Question: Produce a descriptive caption suitable for publication.
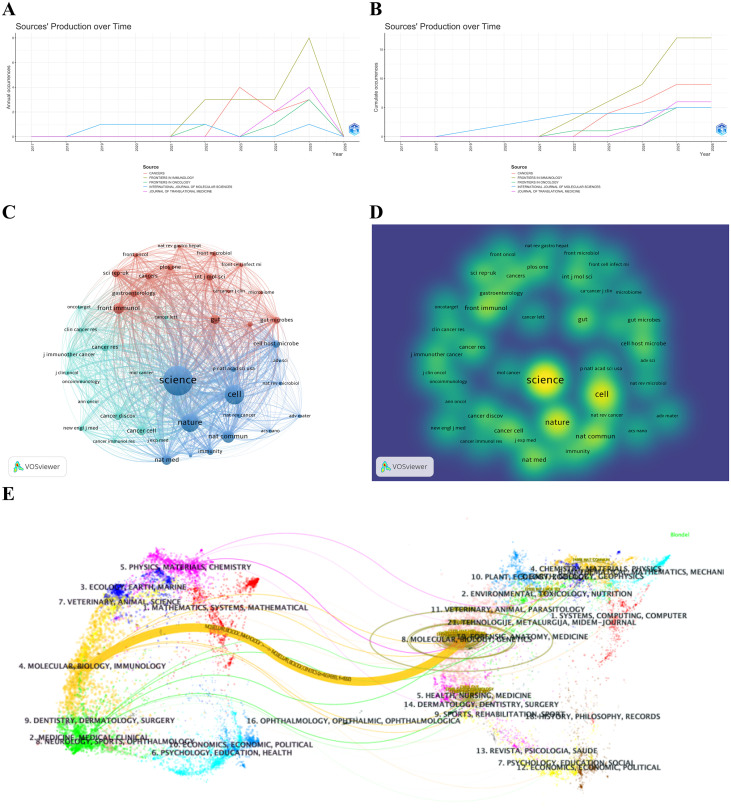
Answer: Journal publication trends and co-citation analysis. (A) Annual publication trends of core journals. (B) Cumulative publication trends of core journals. (C) Co-citation network of journals with at least 100 co-citations (N = 43). Node size is proportional to co-citation frequency. Edge thickness represents co-citation strength. Node colors indicate distinct co-citation clusters identified. (D) Density visualization of co-cited journals. Higher density (yellow) indicates stronger co-citation relationships, concentrated around Nature , Science , and Cell . (E) Dual-map overlay of journals related to the publications. Colored paths indicate citation flows between citing journals (left) and cited journals (right).